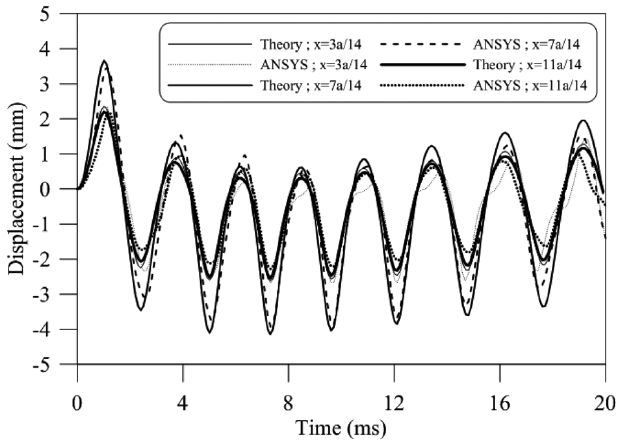
Fig. 7. The displacement-time histories of the simply-supported tapered laminated plates ( β = 1.2).